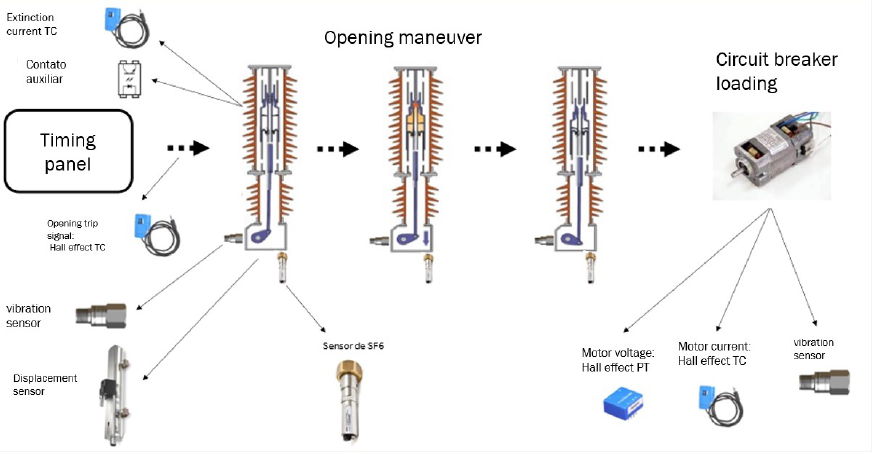
Figure 16. Signals obtained during opening and loading